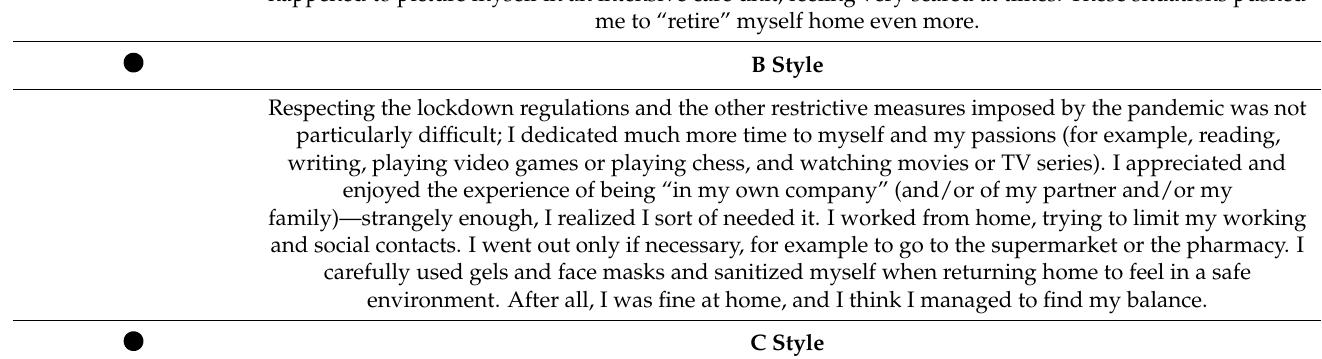
Table A1. Description of four different styles of response to the pandemic and its related restrictive strategies.